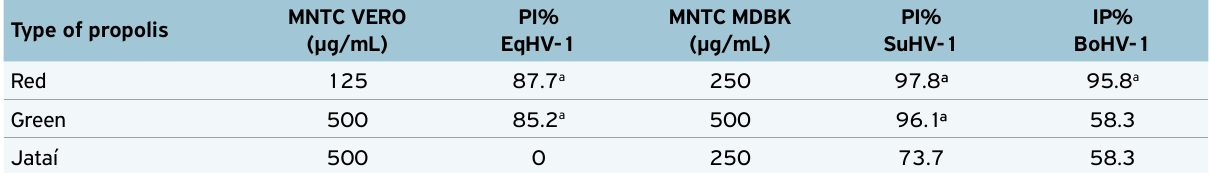
Table 2. Maximim non‑toxic concentration (MNTC) of the three types propolis tested in MDBK and Vero cell lines, and the percentage of inhibition (PI) against equine (EqHV‑1), swine (SuHV‑1) and bovine (BoHV‑1) herpesviruses. Type of propolis